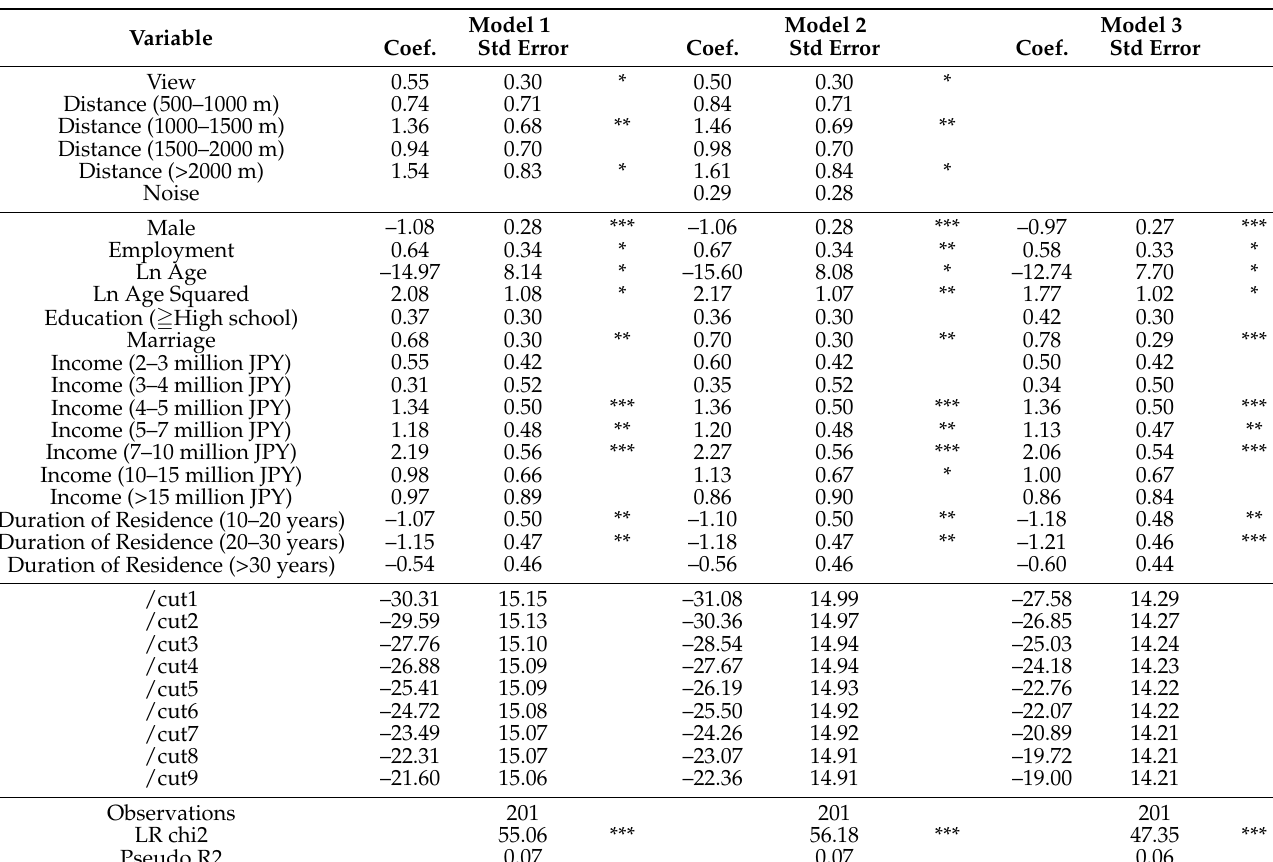
Table 2. Results of ordered probit